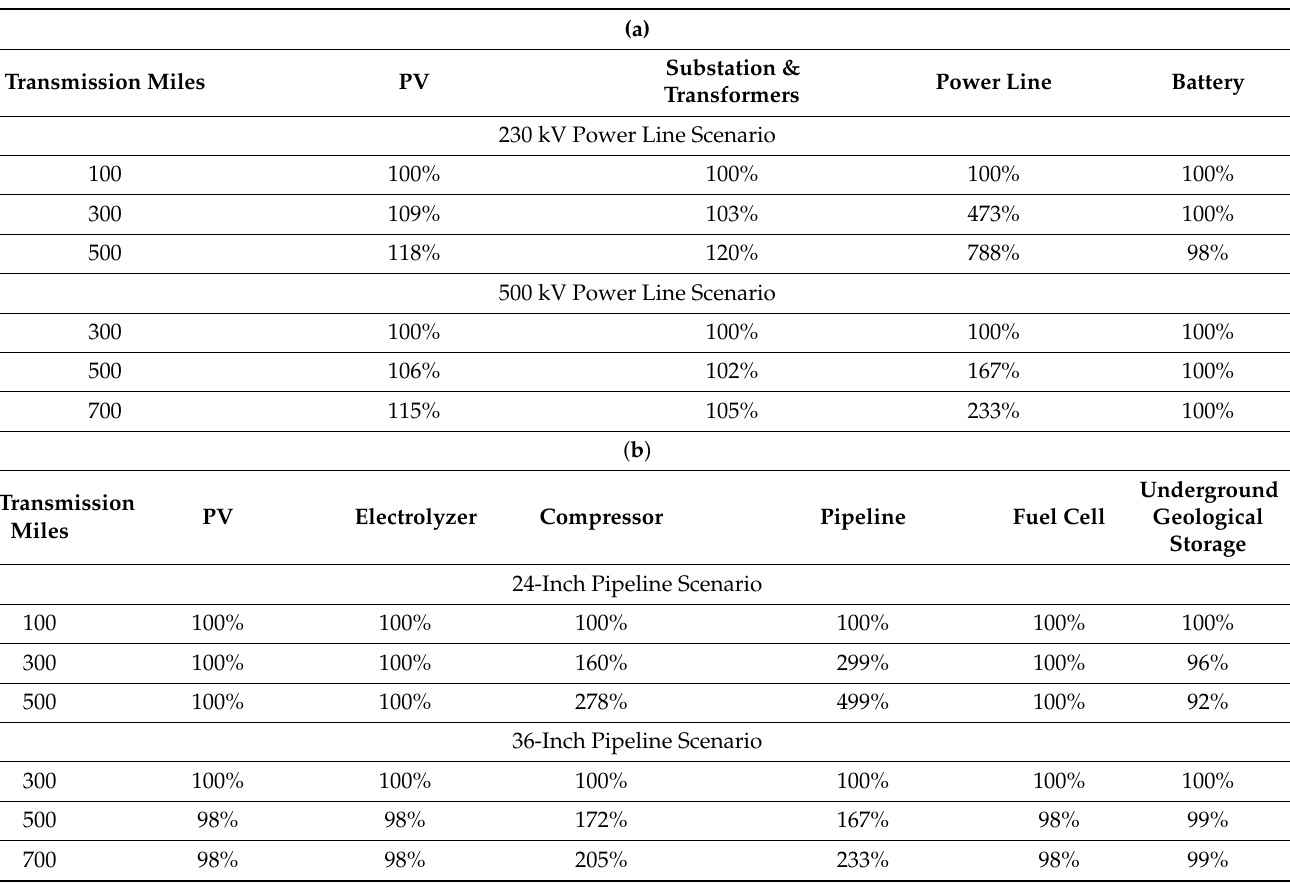
Table 2. Comparing change in component EAC when increasing transmission distance. Numbers are provided as a percentage of the shortest transmission distance scenario for ( a ) the electric scenarios and ( b ) the hydrogen